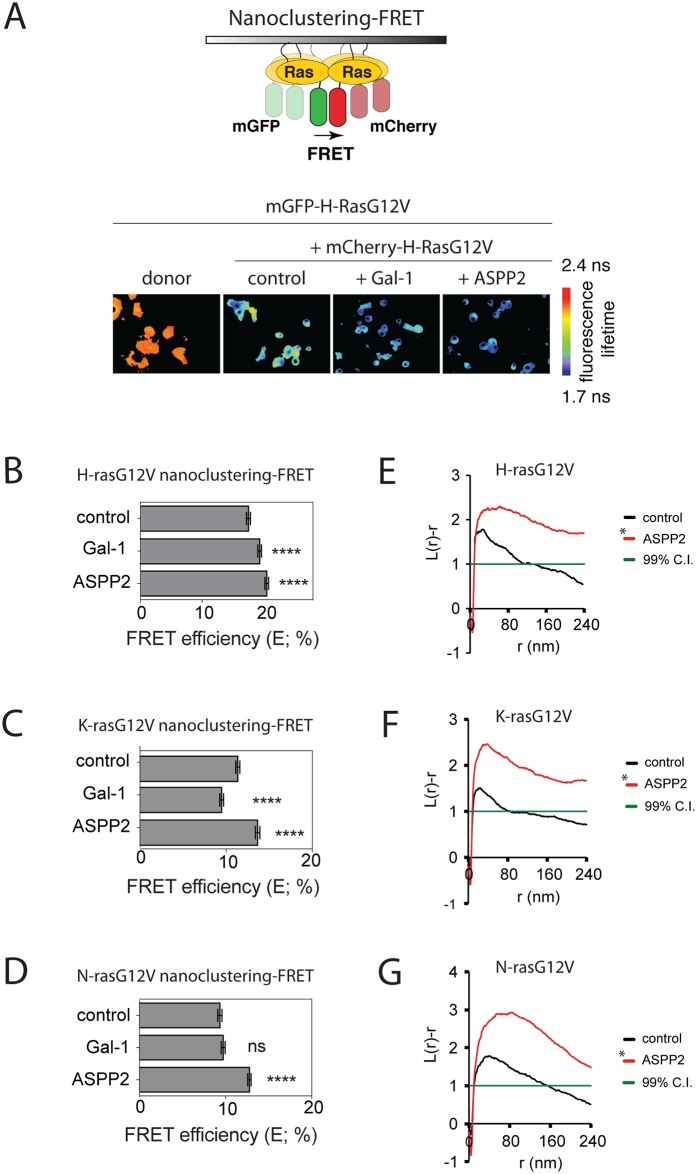
ASPP2 increases oncogenic H-ras, K-ras and N-ras nanoclustering.(A)
Top, scheme explaining nanoclustering-FRET analysis in HEK cells. Green and red ovals represent mGFP- and mCherry-tags, respectively. Bottom, examples of FLIM-FRET images of HEK cells from the different FRET samples as indicated. (B-D) Nanoclustering-FRET analysis in HEK cells coexpressing mGFP- and mCherry-tagged (B) H-rasG12V, (C) K-rasG12V or (D) N-rasG12V. The effect of Gal-1 or ASPP2 expression on nanoclustering-FRET was compared to control samples. Statistical significance of differences between controls and treated samples was examined using one-way ANOVA (mean ± SEM, n = 3; ns, not significant; *, p<0.05, ****, p< 0.0001). (E-G) Electron microscopic nanoclustering analysis of BHK cells expressing mGFP-tagged (E) H-rasG12V, (F) K-rasG12V or (G) N-rasG12V alone or together with ASPP2. mGFP was immunolabeled with 4.5 nm gold nanoparticles coupled to anti-GFP antibody. The spatial distribution of gold particles was evaluated using univariate K-function, where L(r)–r values indicate the extent of nanoclustering as a function of length scale, r, in nm. At least 15 images were analysed for each condition. Statistical significance between different conditions was evaluated using bootstrap tests. Averaged curves are shown for each condition.